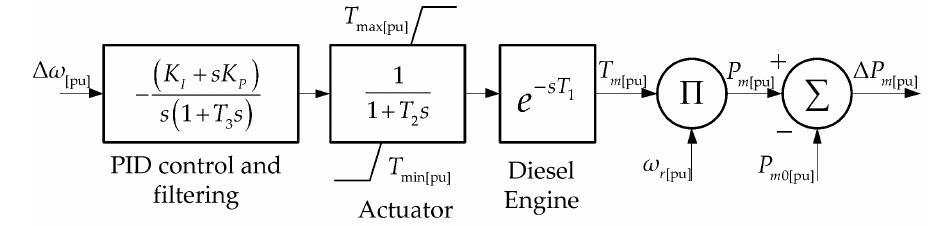
Figure 2. Simplified model of the diesel generation